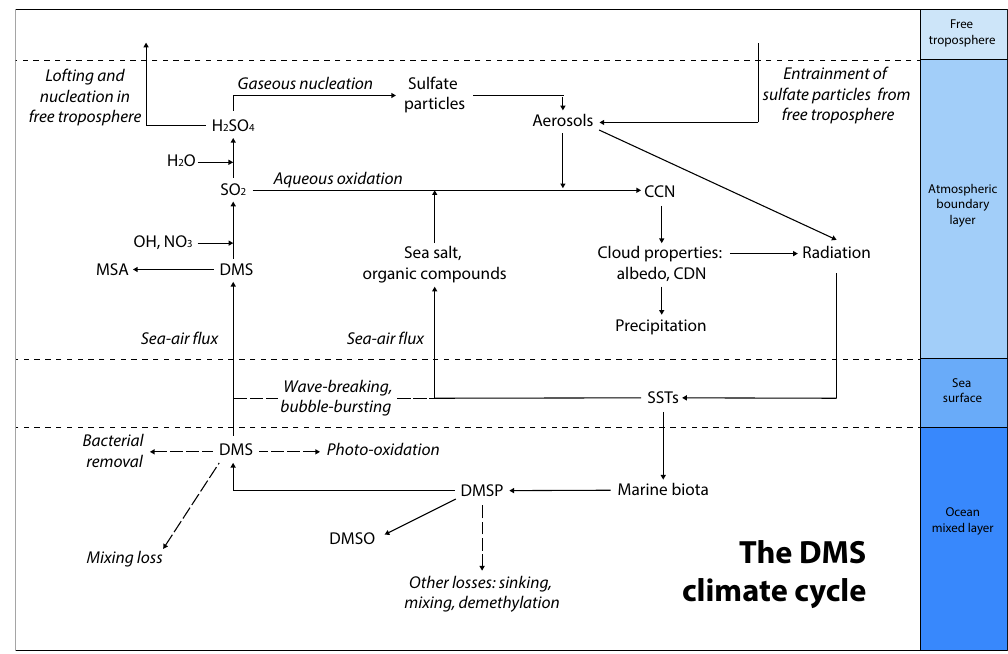
Figure 1. Schematic diagram showing the ocean–atmosphere sulfur life cycle and climate-relevant processes. Acronyms are defined as follows: sea surface temperatures (SSTs), methane sulfonic acid (MSA), dimethylsulfoniopropionate (DMSP), dimethyl sulfoxide (DMSO), dimethyl sulfide (DMS), cloud condensation nuclei (CCN) and cloud droplet number